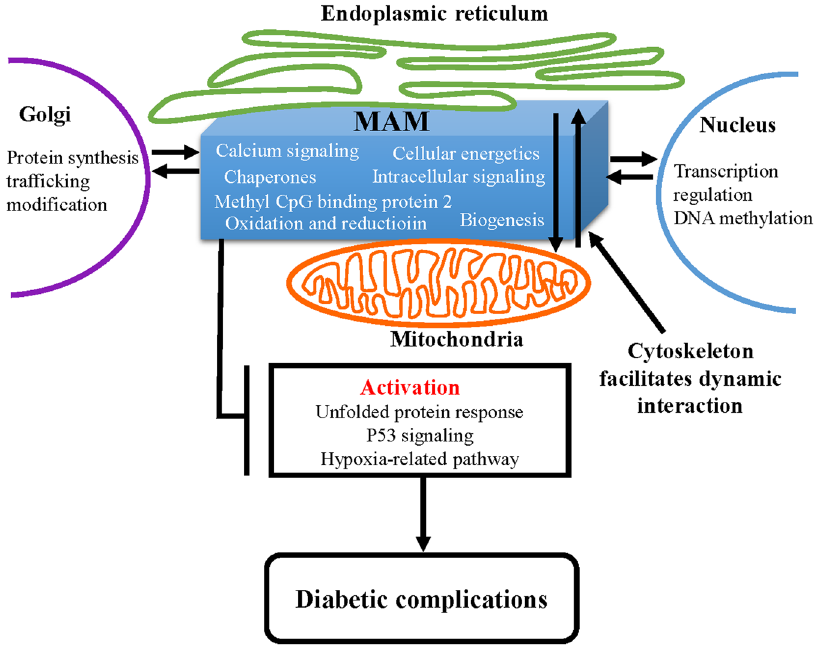
Figure 8. Schematic summary of signaling pathways associated with MAM dysfunction in the pathogenesis of diabetic